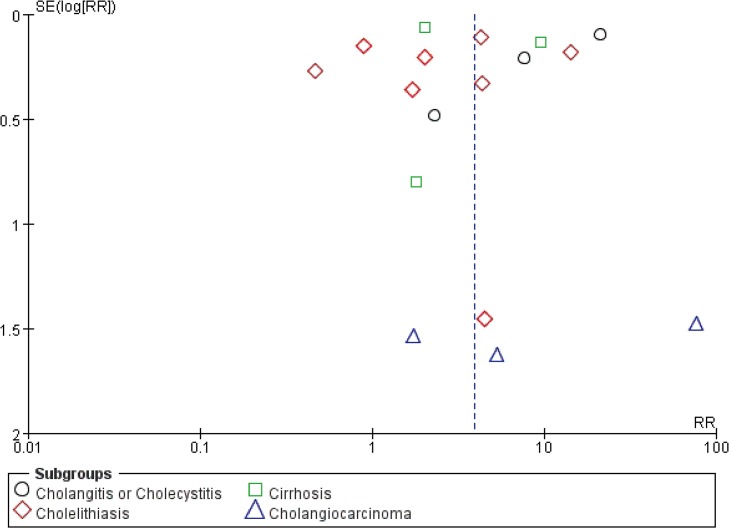
Funnel plot of cohort studies to detect publication bias.